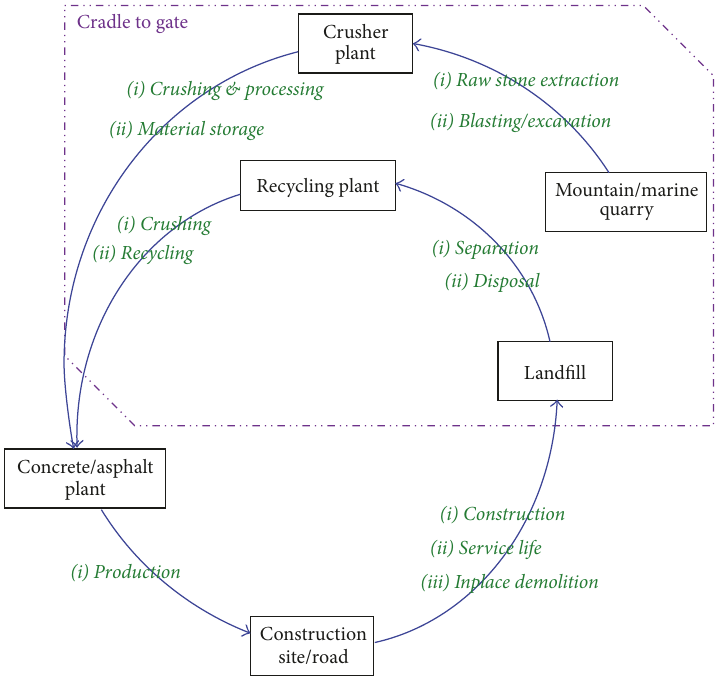
Figure 1: Cradle-to-grave and cradle-to-gate life-cycle assessment for aggregate.